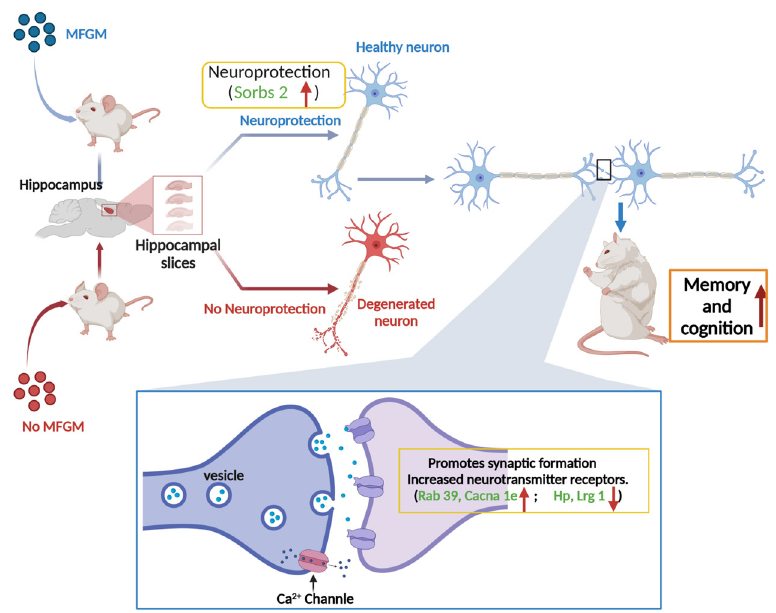
Figure 6. Schematic diagram of synaptogenesis and neurotransmission facilitation in cognitive and memory function enhancement by MFGM intervention.